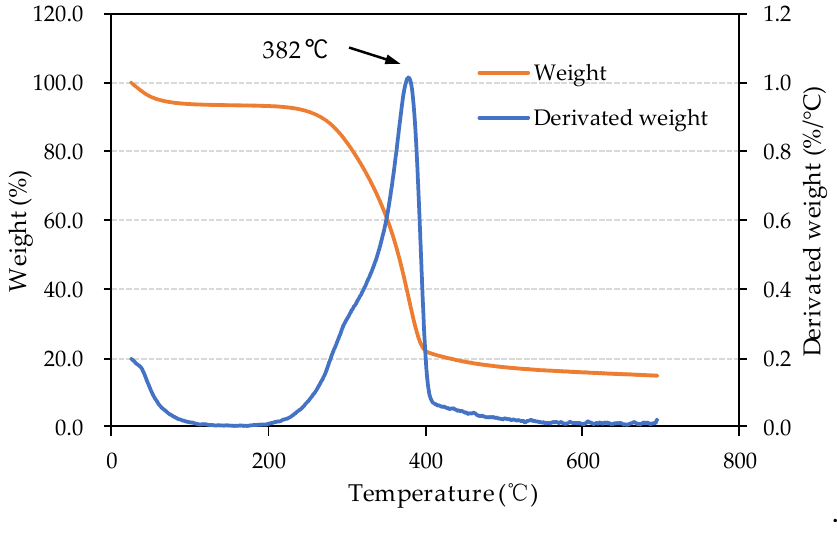
Figure 4. TG and DTG curves of the samples.